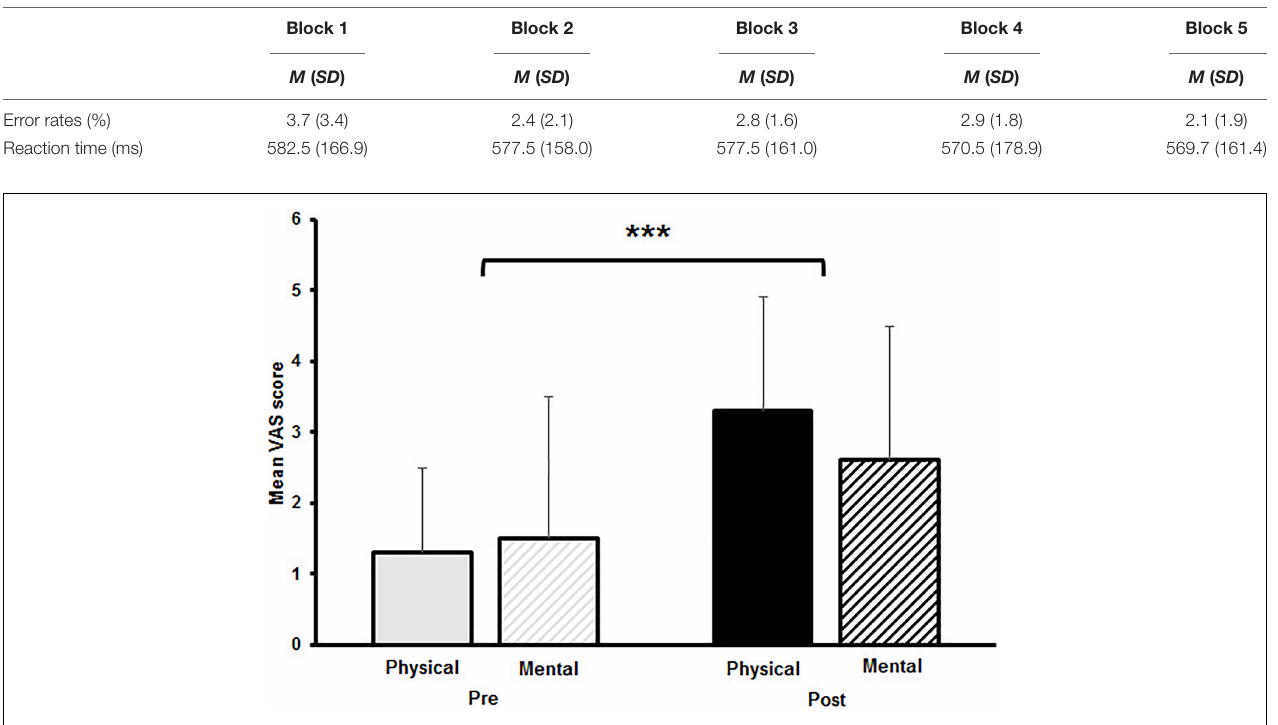
TABLE 2 | Error rates and reaction times for the different blocks of the attention network test presented as mean with standard deviation across all participants.